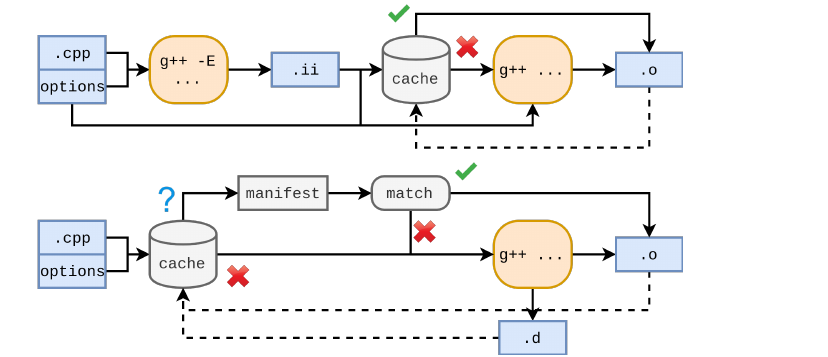
Figure 2. Schematic view of the (top) "preprocessor" and (bottom) "depend" mode of ccache. In the former the C preprocessor is invoked every time, while in the latter the dependencies produced by the compiler are used.